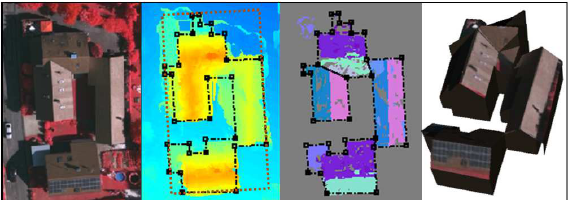
Figure 5: Building reconstruction procedure. From left to